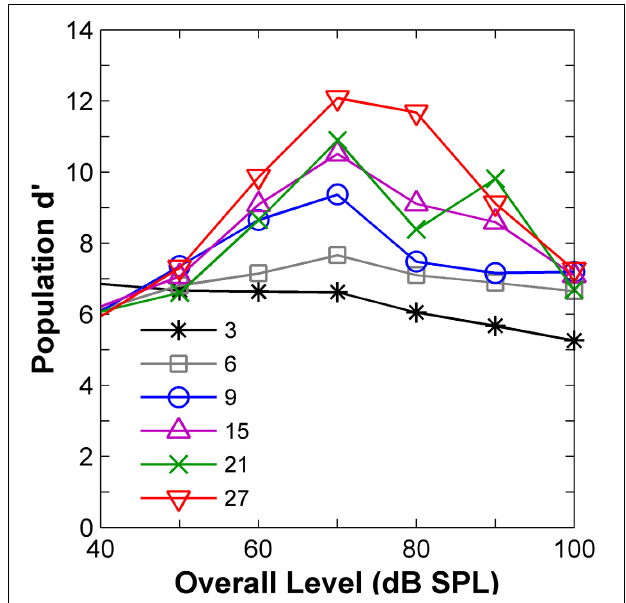
FIGURE 5 | Auditory nerve data: population d (cid:2) as a function of the noise overall level. The numbers in the inset indicate notch depths in dB re spectrum level of the notch side bands.